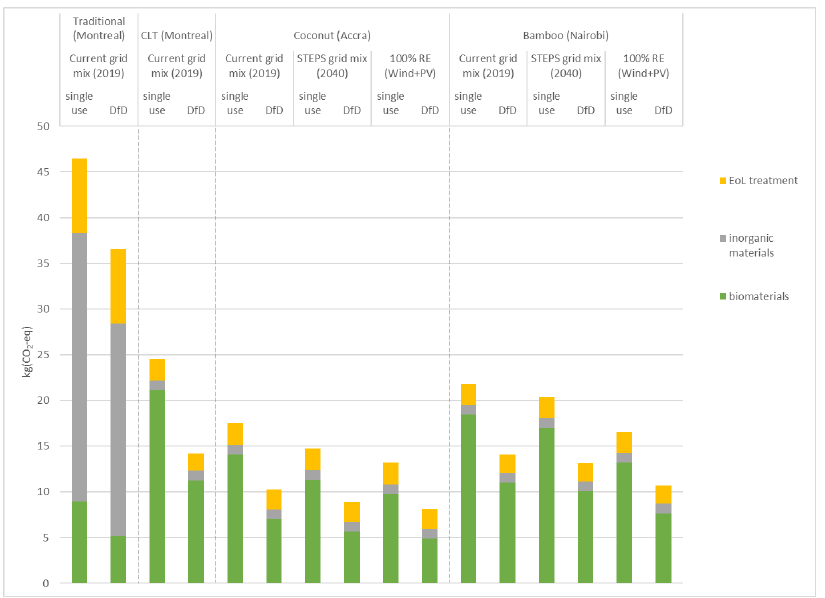
Figure 5. Global warming potential (fossil) results for the four wall assemblies and locations, with sensitivity analyses (FU = 1 m 2 ).